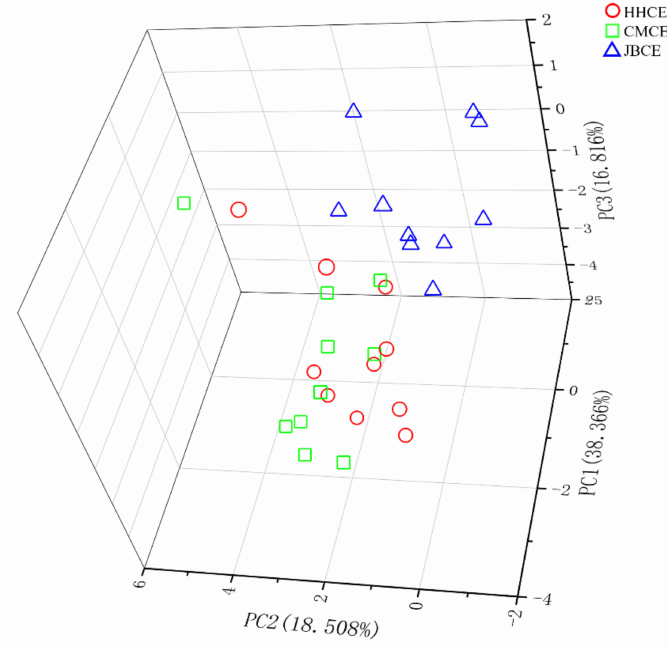
Figure 4. Principal component analysis of Coilia nasus from the Nantong coastal area of the Yellow Sea (HHCE), the Changjiang estuary near the Jiuduansha Shoal (CMCE), and the Jiubao bridge waters in the Qiantang estuary (JBCE), based on microchemical characteristics of the otolith core. Those of HHCE and CMCE were mixed well, while those of JBCE were independent from the